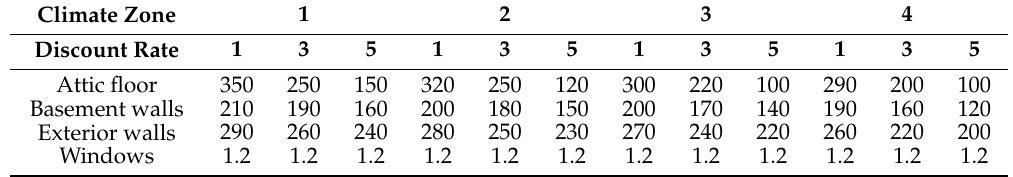
Table 8. Optimum insulation thickness (mm) and windows U ‐ value W/m 2 K for the energy renovation of building envelope components, in different zones and for different discount rates.